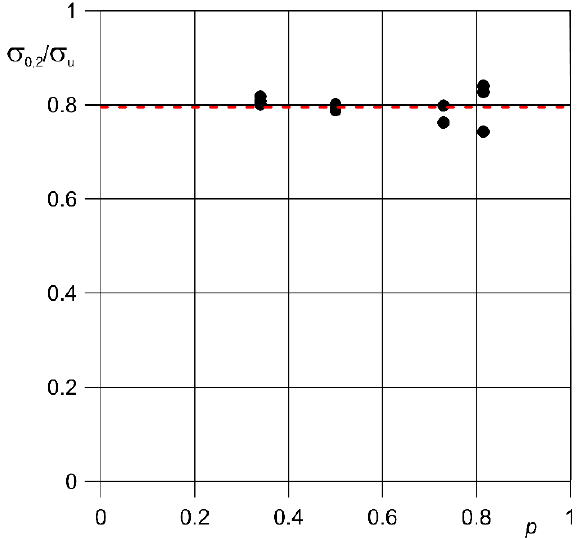
Table 4. Averaged values of the effective yield strength to tensile strength of Ti6Al4V titanium alloy samples of different porosity, obtained by LPBF method.